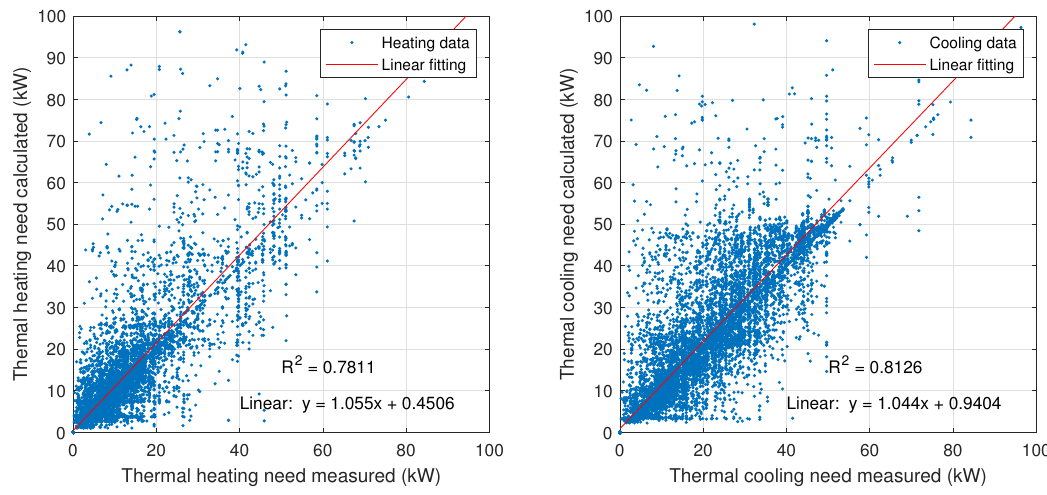
Figure 6. Fitting of the data with the model in heating ( left ) and cooling ( right